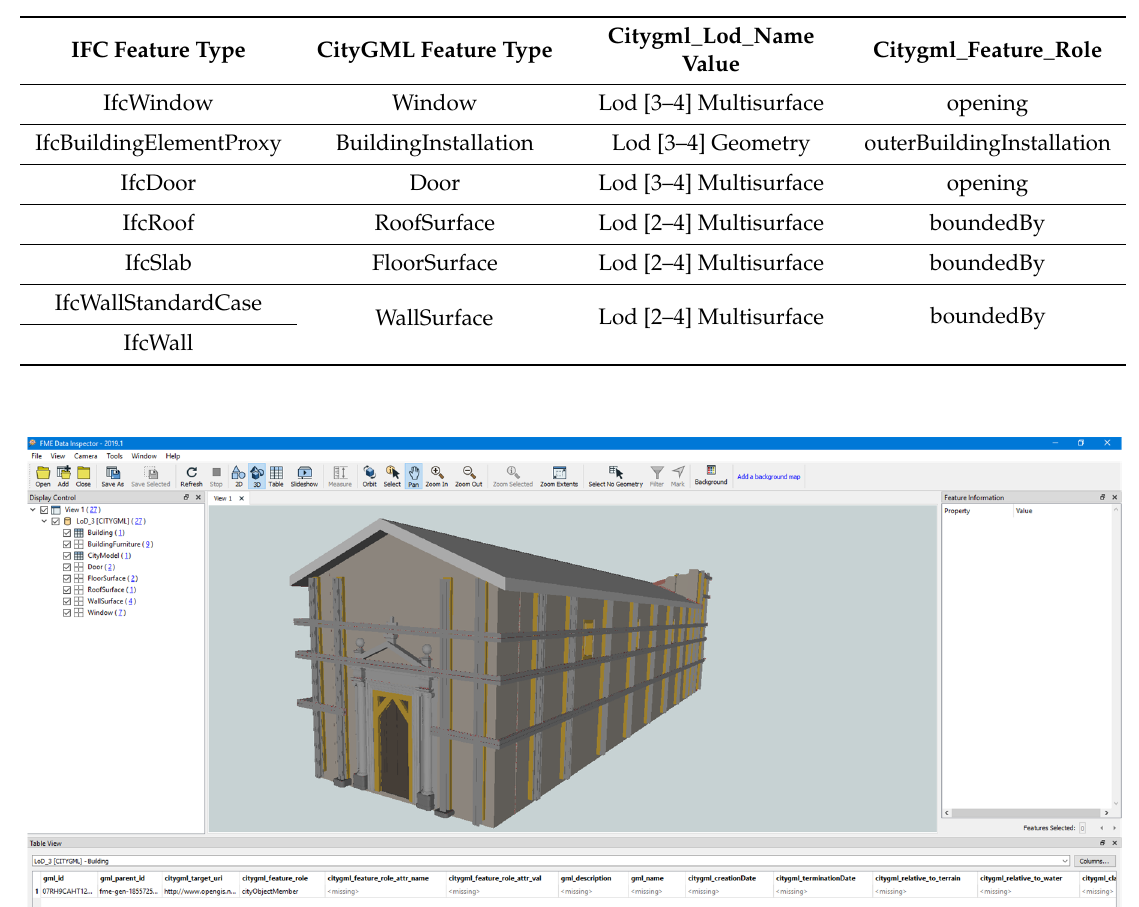
Table 4. Corresponces beetween IFC and CityGML features and geometries.